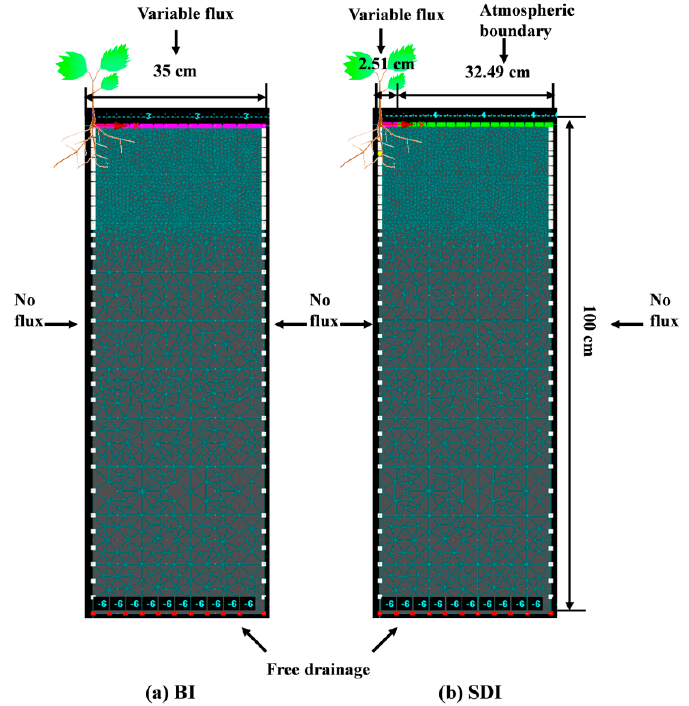
Figure 5. Domain geometry, grid size and boundary conditions used in the HYDRUS-2D model under different irrigation methods. Abbreviations: BI, border irrigation; and SDI, surface drip irrigation.